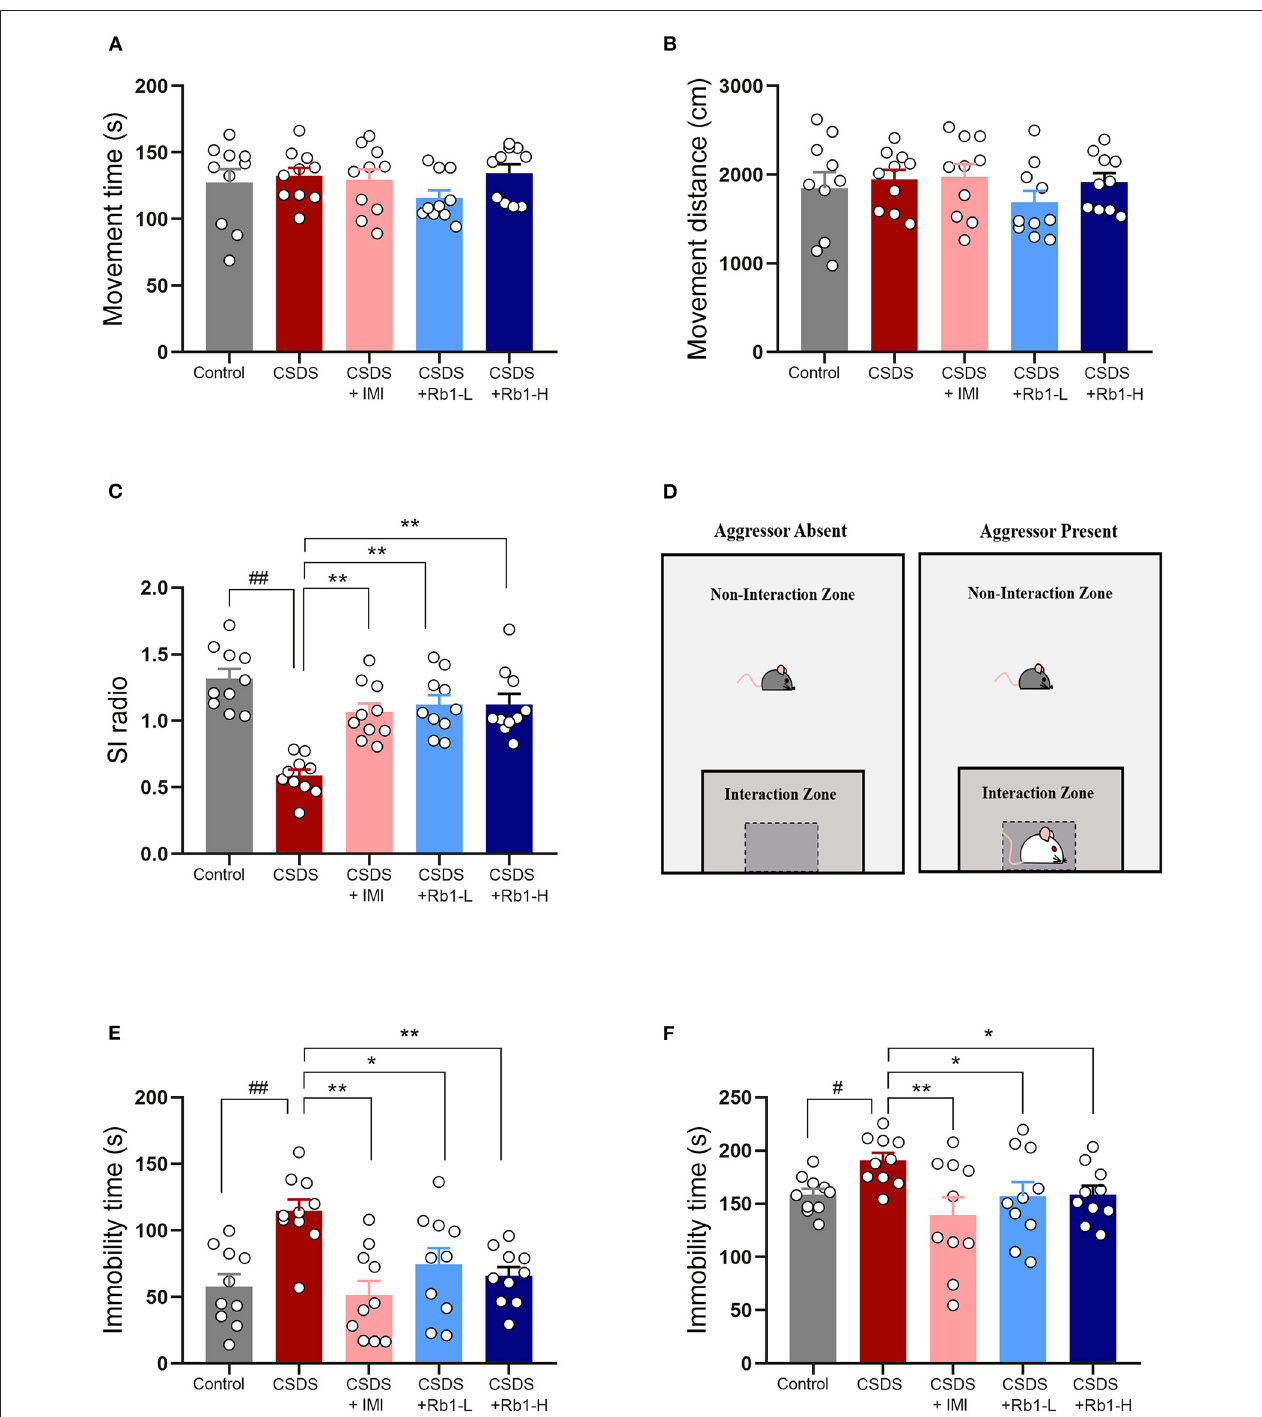
FIGURE 2 | The Rb1 treatment enhanced CSDS-induced depression-like behavior. (A,B) Open field test (OFT); (C) Social interaction test (SIT); (D) Aggressor approach—social interaction test paradigm; (E) Tail suspension test (TST); (F) Forced swim test (FST). The entire data is presented and articulated as means ± SEM; N = 10 mice per group. # p, and ## p < 0.05, and 0.01, substantially varied from control; * p and ** p < 0.05, and 0.01, significantly differed from CSDS group. microglia in the DG of non-stressed mice possessed fewer and scattered processes, while CSDS-treated mice had larger cell bodies with thick and condensed processes ( Figures 5E,F ). ( Figure 5G ; p < 0.01). Rb1 inhibited microglia